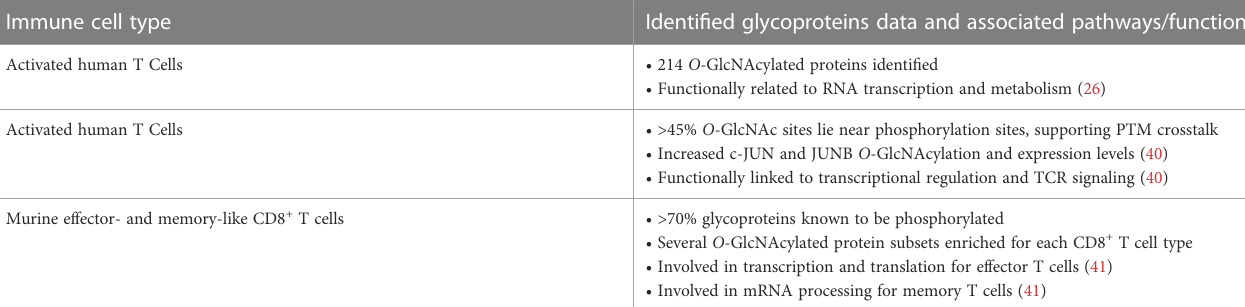
TABLE 3 Functional links between the identi fi ed O -GlcNAc proteins in T cells and potential associated pathways. Immune cell type Identi fi ed glycoproteins data and associated